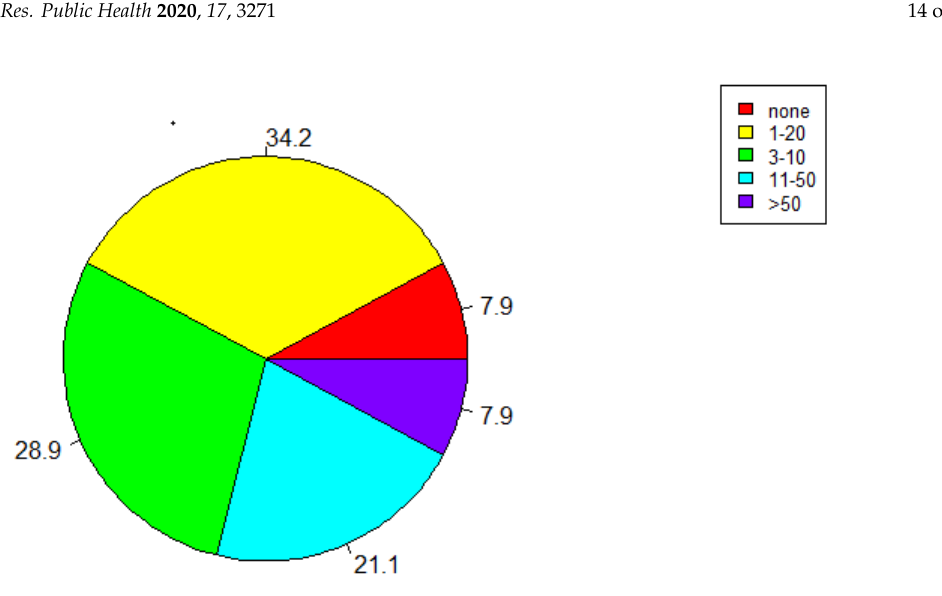
relevant to you?” Figure 9. “How many times do you think you would use this platform in the next 12 months if it was